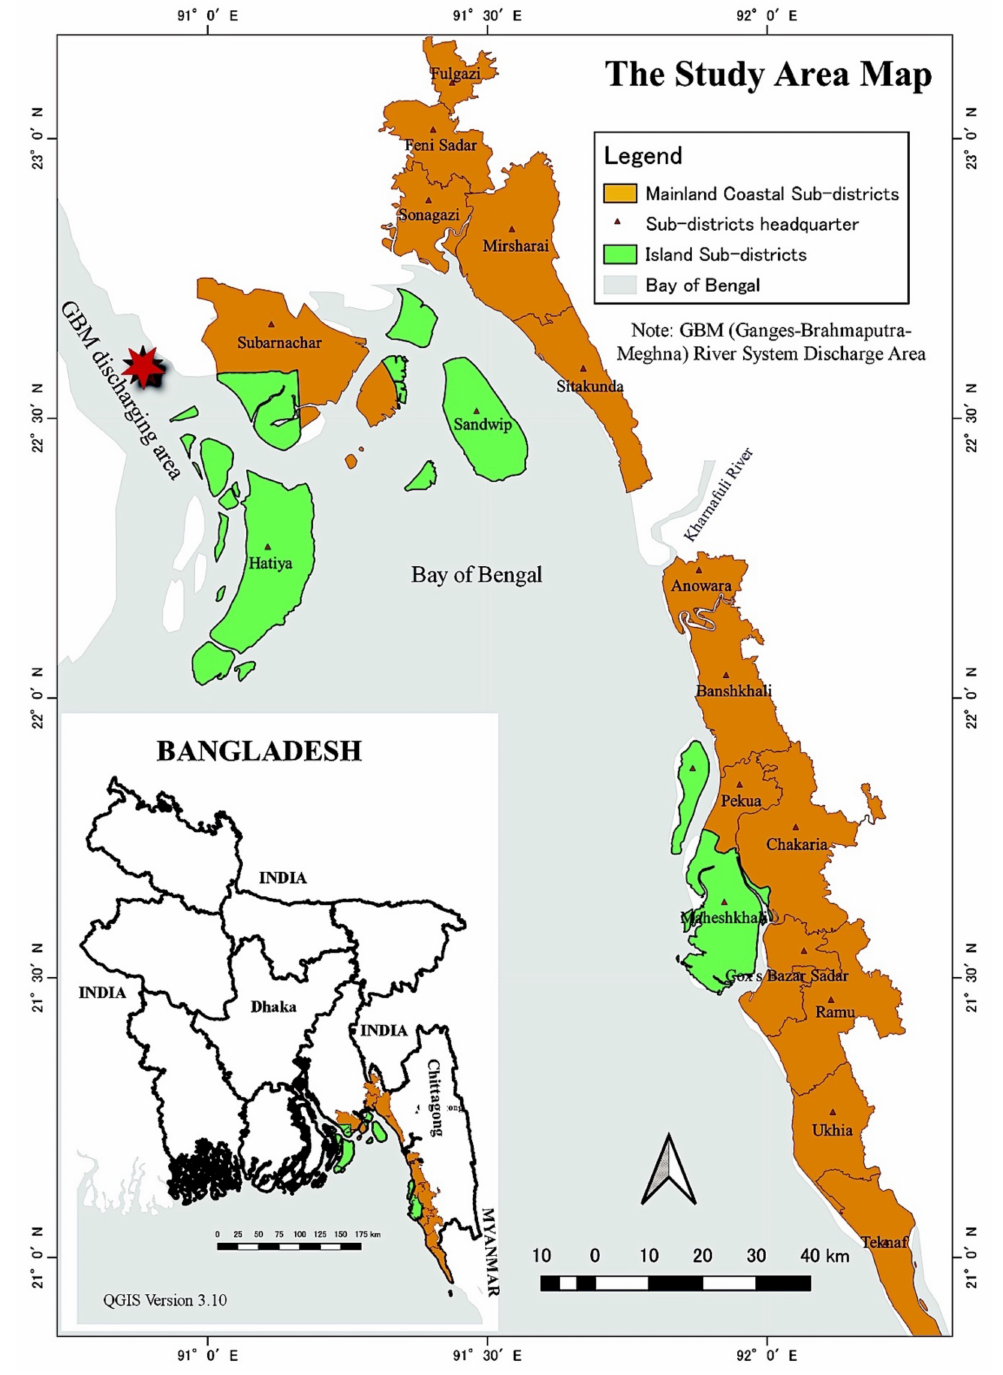
Figure 1. Location map of the study area. Orange areas indicate coastal mainland subdistricts, and green areas indicate island